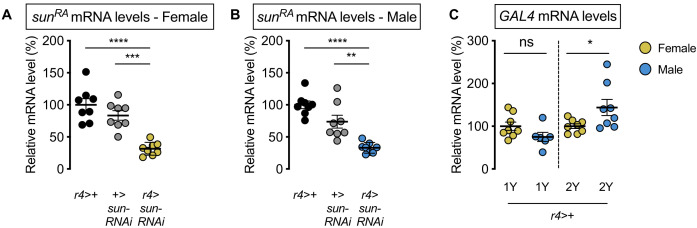
Validation of stunted (sun) knockdown.(A) mRNA levels of stunted (sunRA) were significantly lower in r4-GAL4>UAS-sun-RNAi females compared with r4-GAL4>+ and +>UAS-sun-RNAi control females (p<0.0001 and p=0.0001, respectively; one-way ANOVA followed by Tukey HSD test). n = 8 biological replicates. (B) mRNA levels of stunted (sunRA) were significantly lower in r4-GAL4>UAS-sun-RNAi males compared with r4-GAL4>+ and +>UAS-sun-RNAi control males (p<0.0001 and p=0.0012, respectively; one-way ANOVA followed by Tukey HSD test). n = 8 biological replicates. (C) Levels of GAL4 mRNA were not significantly different between the sexes in larvae raised in 1Y (p=0.1105; Student’s t test), whereas GAL4 mRNA levels were significantly higher in males in 2Y (p=0.0428; Student’s t test). n = 6–8 biological replicates. * indicates p<0.05, ** indicates p<0.01, *** indicates p<0.001, **** indicates p<0.0001; ns indicates not significant; error bars indicate SEM.